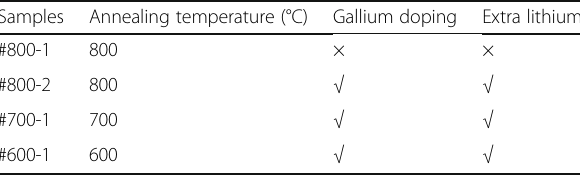
Table 1 Samples of LLZO thin film solid electrolyte and their preparation parameters